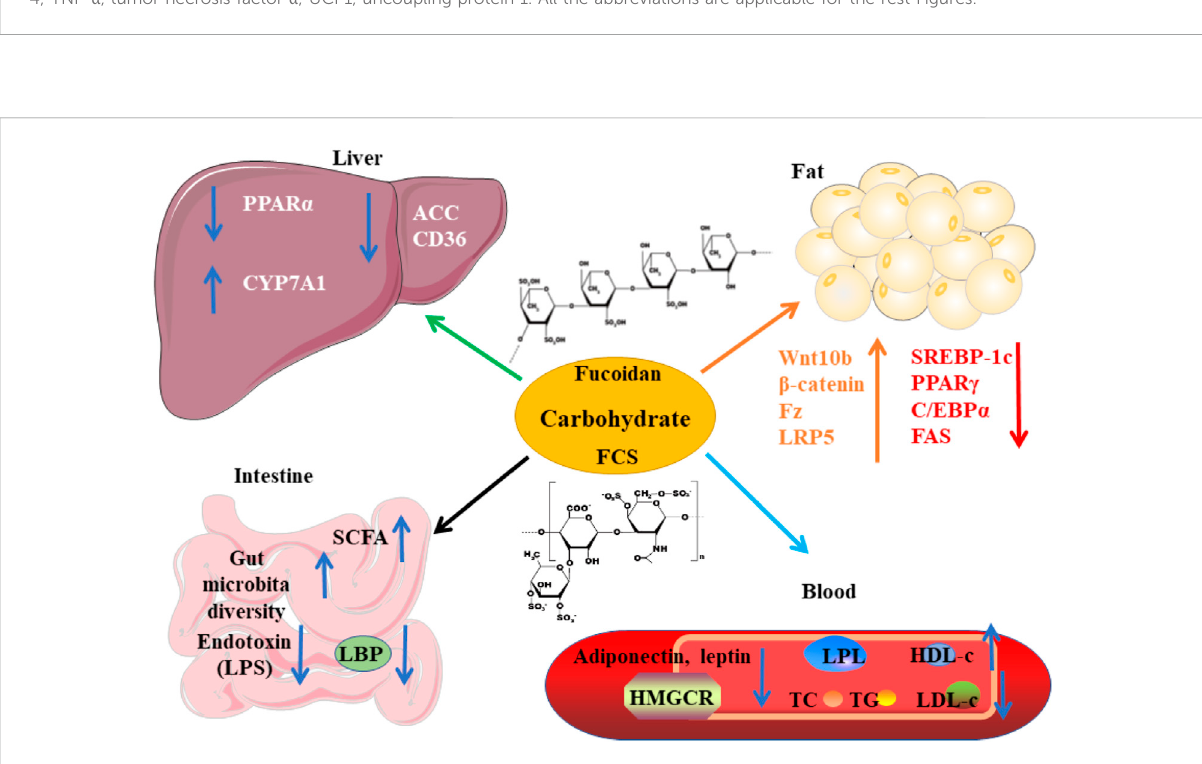
FIGURE 6 Themechanismsofactionofcarbohydratesderivedfromseacucumbers.Thesepolysaccharidesincludefucoidanandfucosylatedchondroitin sulfate (FCS). HDL-c,high-density lipoproteincholesterol;LBP, lipopolysaccharide binding protein; LDL-c, low-density lipoproteincholesterol;LPS, lipopolysaccharide; TC, total cholesterol; TG, triglyceride. All the abbreviations are applicable for the rest